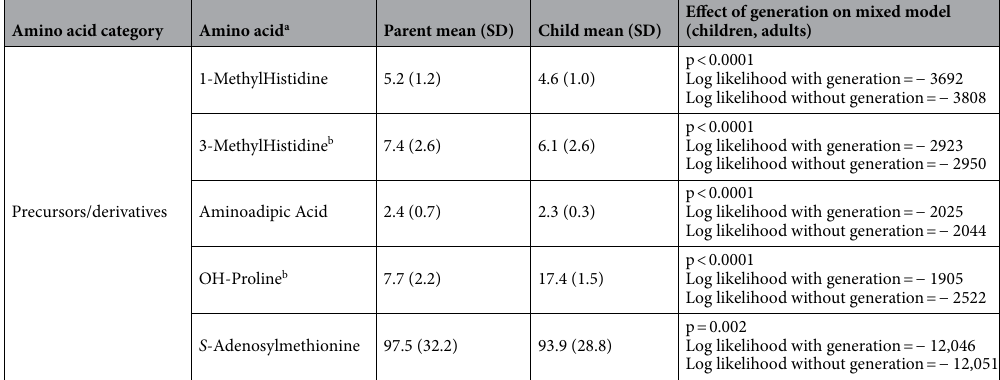
Table 3. Means, standard deviations (SDs) and generation effects of amino acids Table 3: Means, standard deviations (SDs) and generation effects of amino acids. a All in µM except for S -Adenosylmethionine in nM. b Log transformed variables with back-transformed means and standard deviations.